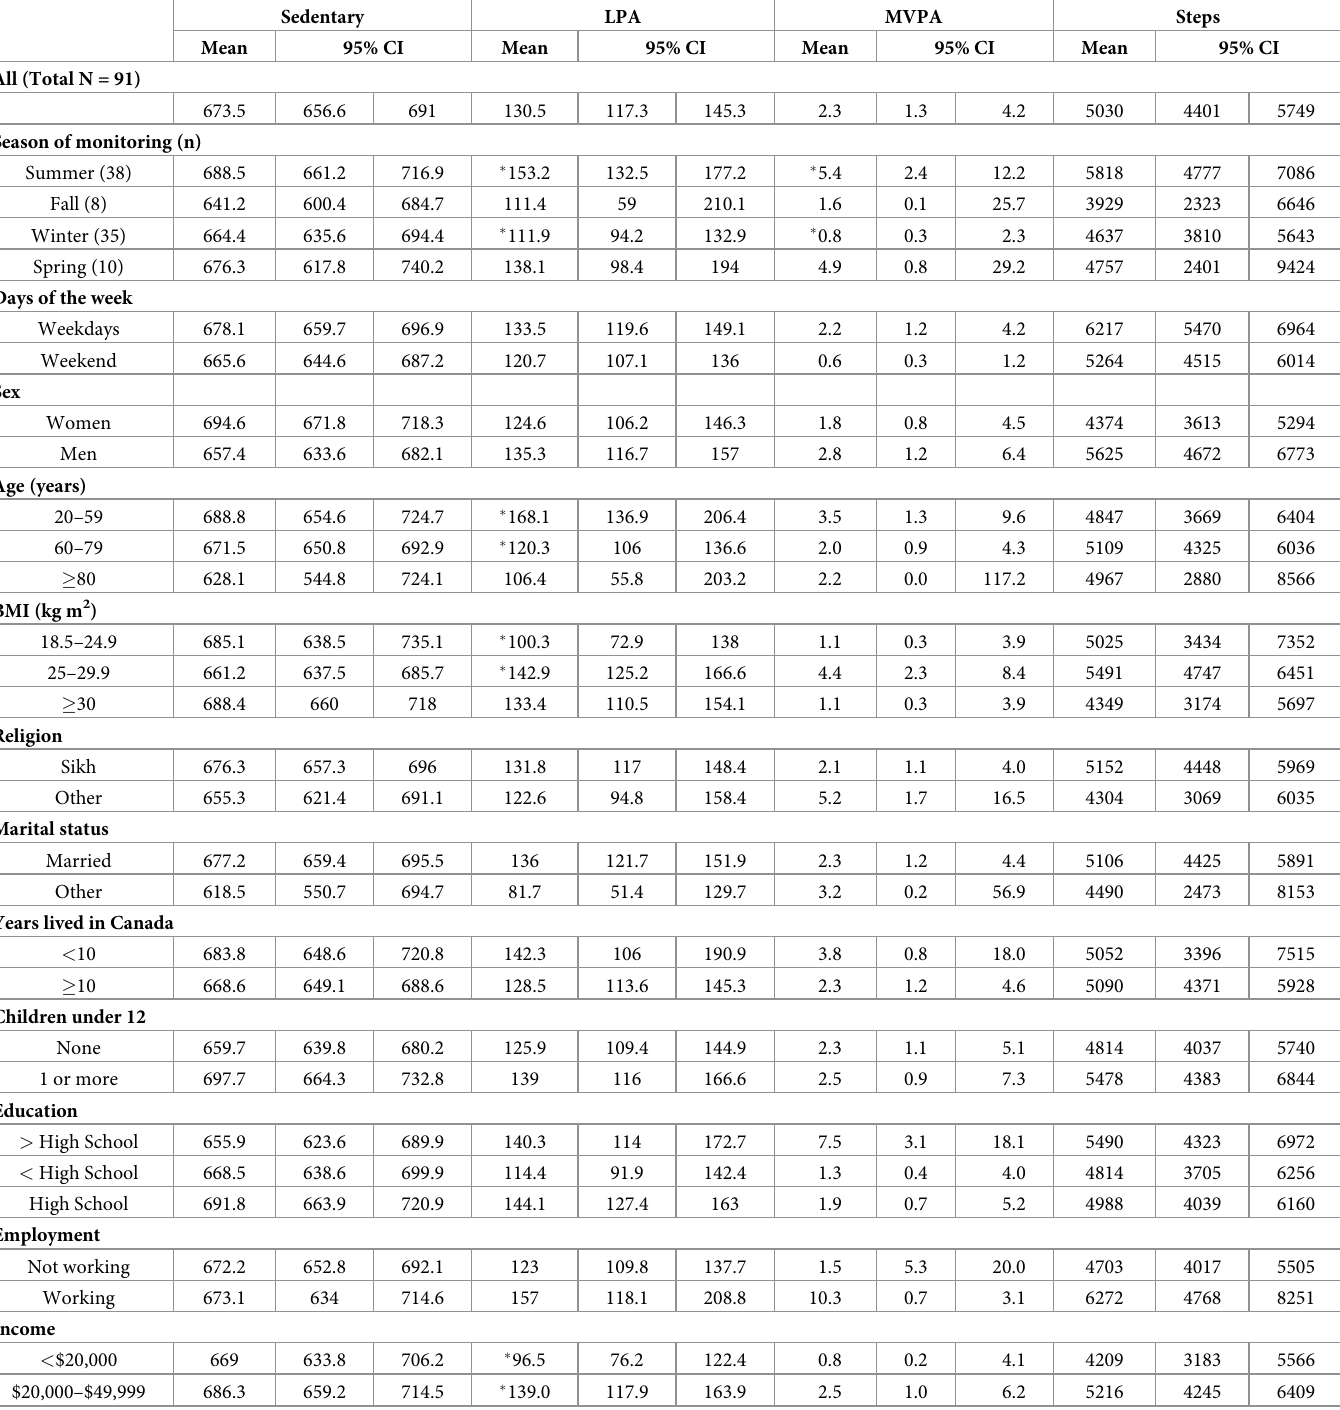
Table 2. Mean daily minutes of sedentary time, LPA, MVPA and average daily step